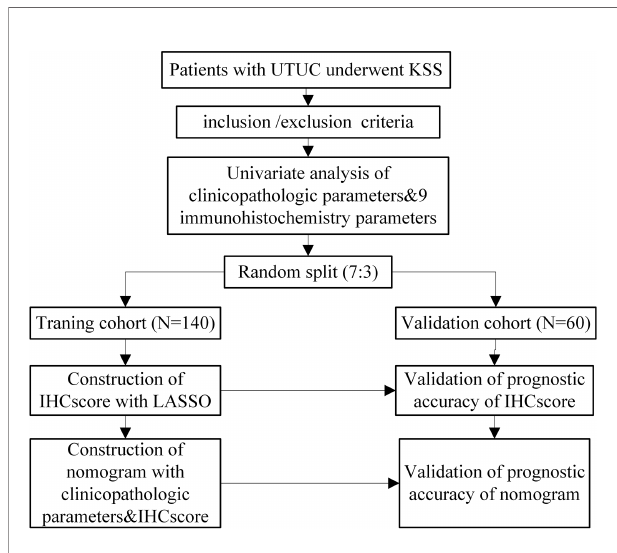
FIGURE 1 | A fl ow-diagram of the present